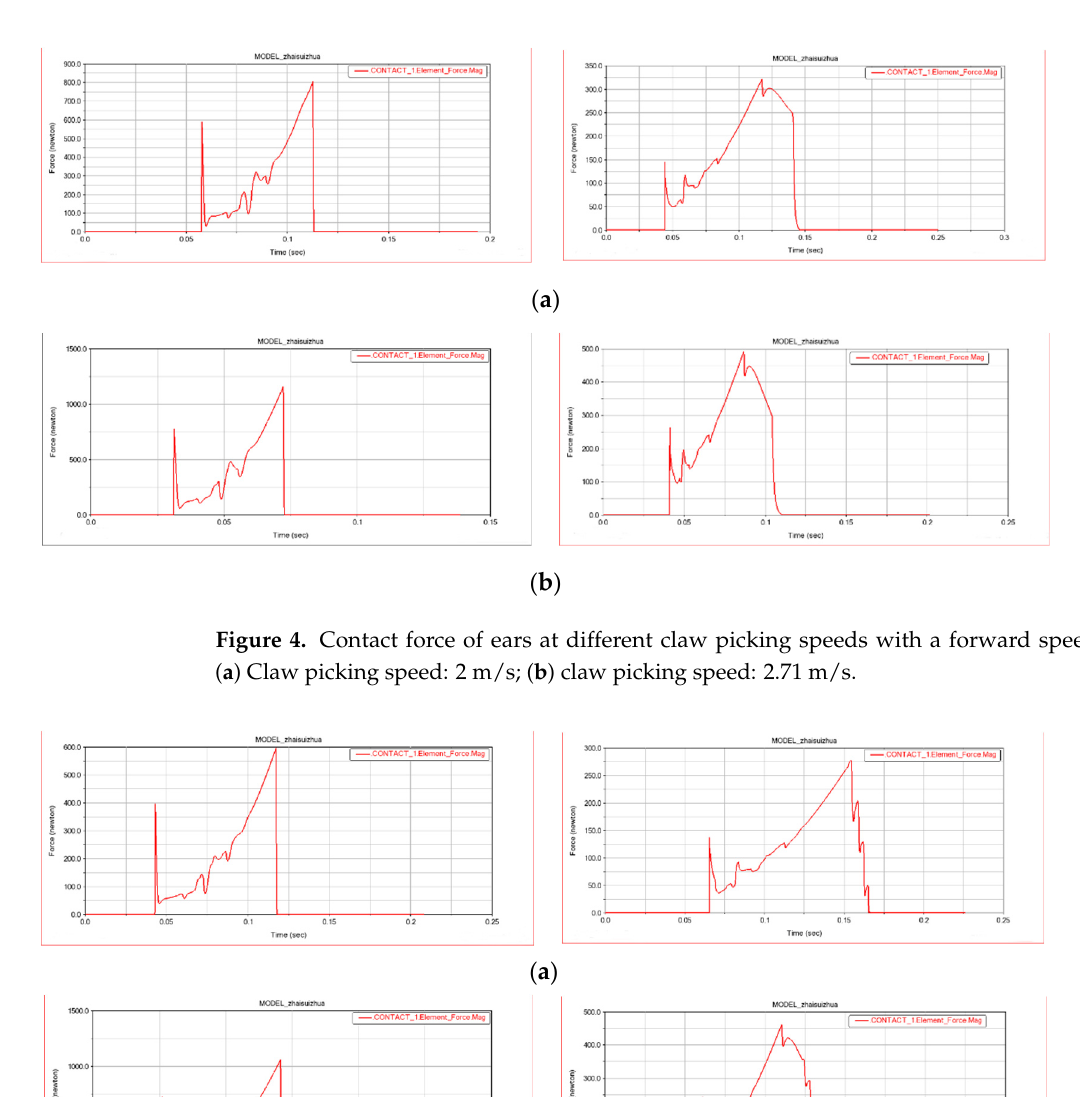
Figure 3. Contact force of ears at different claw picking speeds with a forward speed of 0.5 m/s. ( a ) Claw picking speed: 1.5 m/s; ( b ) claw picking speed: 2.5 m/s.